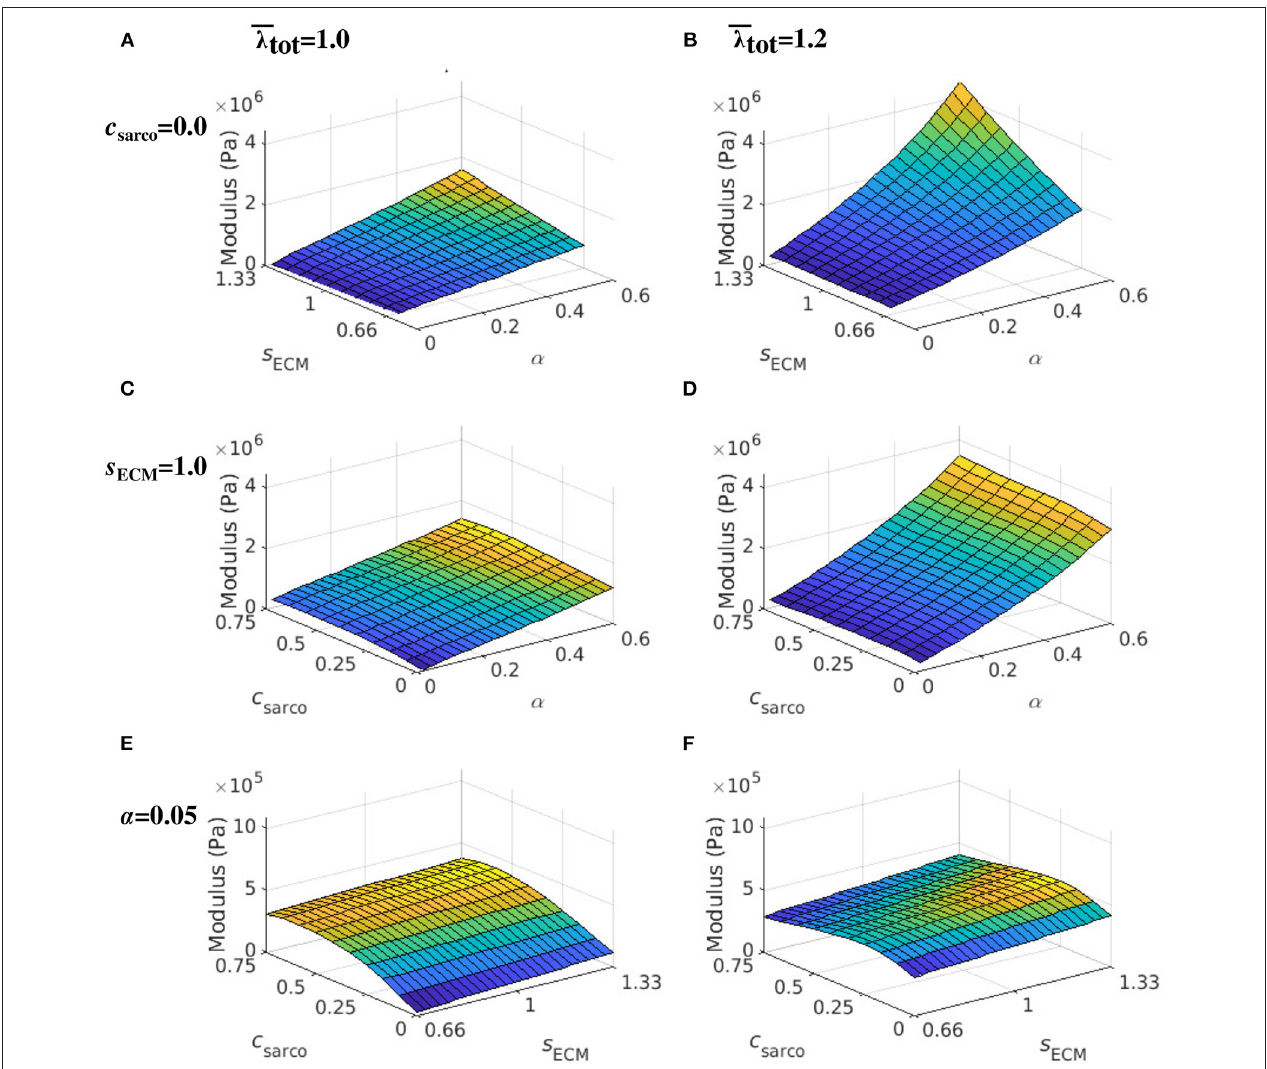
FIGURE 7 | Surface plot of the whole muscle modulus at an average muscle stretch, λ tot , of 1.0 (A,C,E) and 1.2 (B,D,F) . The ECM stiffness factor, s ECM , was varied between values of 0.66 and 1.33; ECM volume fraction, α , from 0.02 to 0.6; and shift in sarcomere stretch, c sarco , from 0.0 to 0.75. Modulus values were extracted from passive lengthening simulations with c sarco = 0.0 in (A,B) ; s ECM = 1.0 in (C,D) ; and α = 0.05 in (E,F)